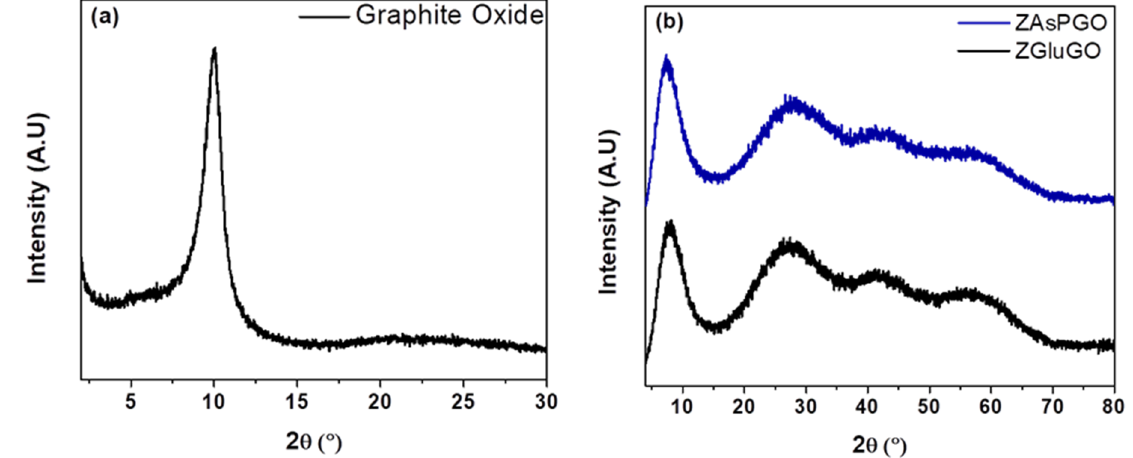
Figure 1. X-ray diffraction patterns for ( a ) graphite oxide, ( b ) ZGluGO and ZAspGO compounds.